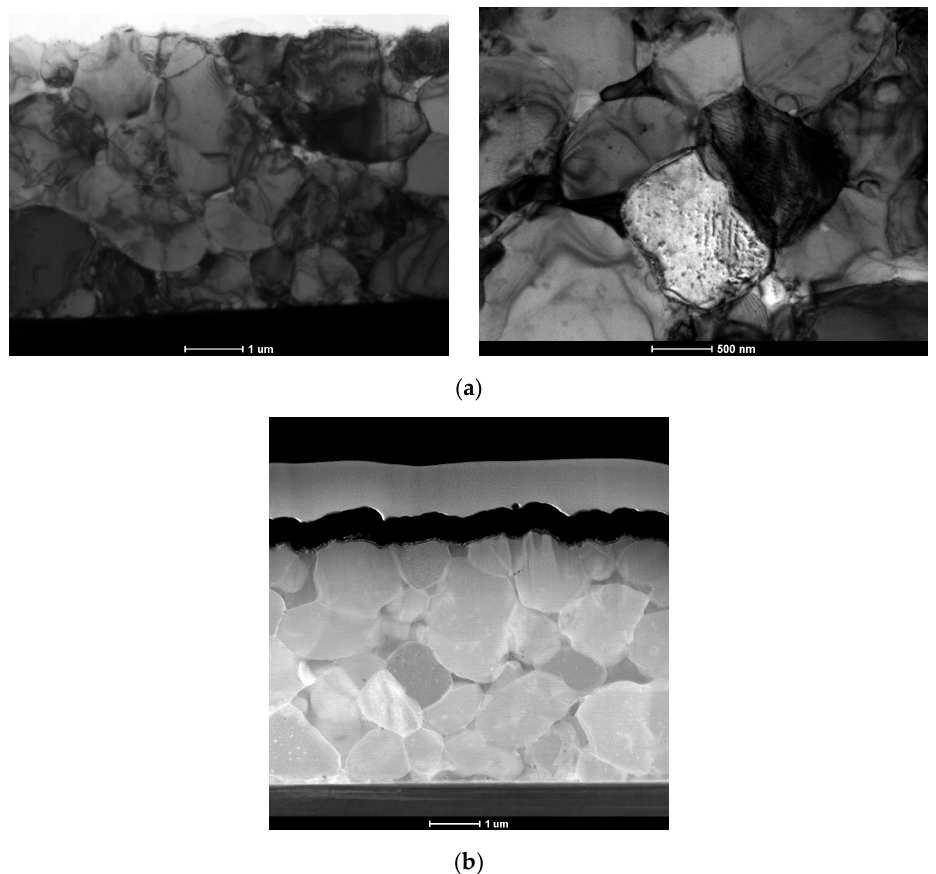
Figure 7. ( a ) HREM of a Ni/Al multilayer thin film, and ( b ) FFT of the grain marked in red.